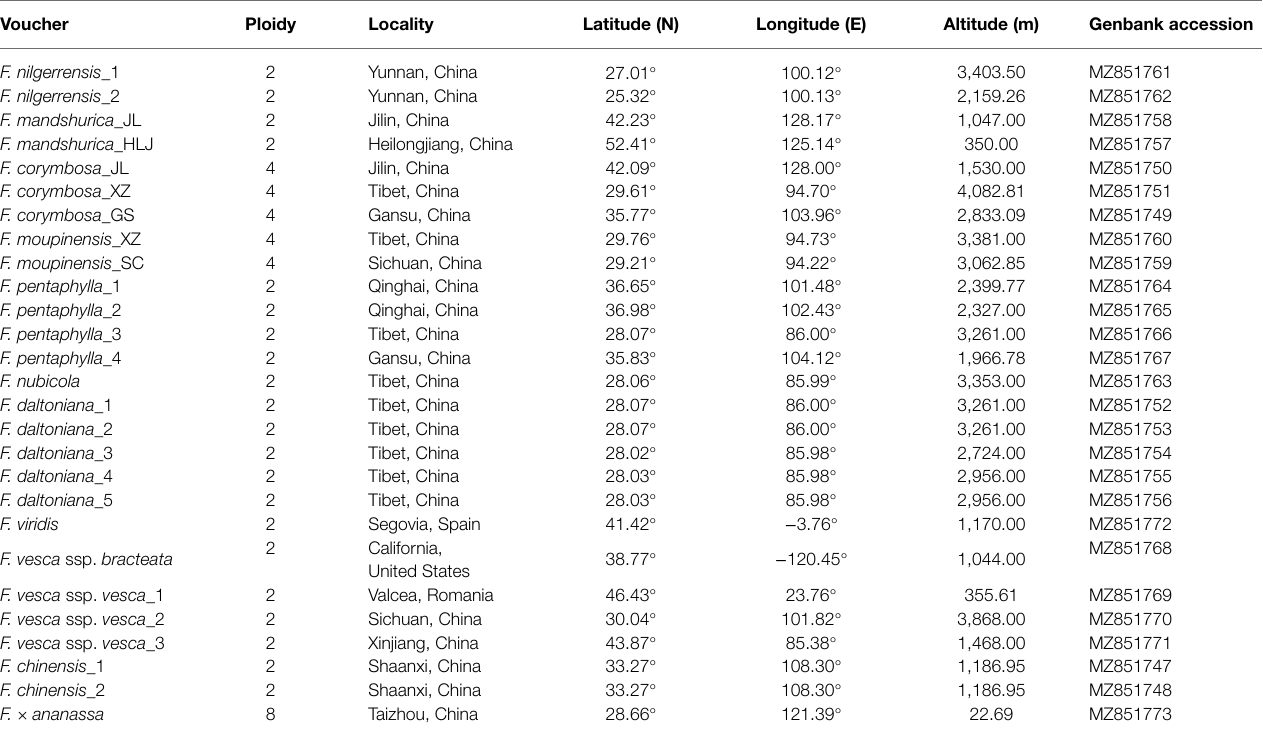
TABLE 1 | Fragaria species collection